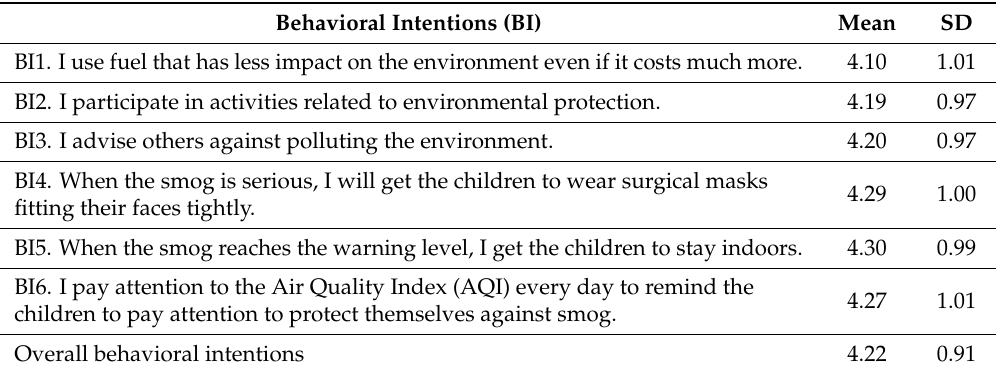
Table 9. Descriptive statistics for anti-PM2.5 behavioral intentions (BI)-related items. PM2.5: fine particulate matter with an aerodynamic diameter of ≤ 2.5 µ